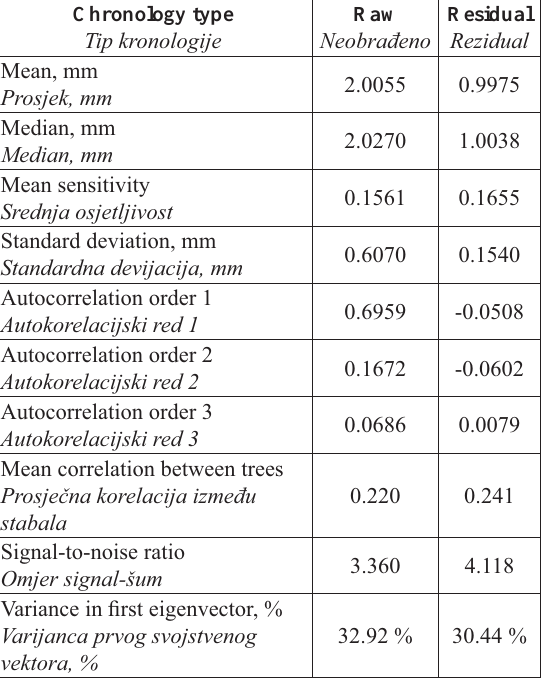
Table 1 Descriptive statistics of Kobiljak near Zagreb (HR1) oak chronology, period 1922-2009, based on 17 trees Tablica 1 . Opisna statistika kronologije hrasta iz Kobiljaka pokraj Zagreba (HR1), razdoblje 1922. -2009., utemeljene na 17 stabala